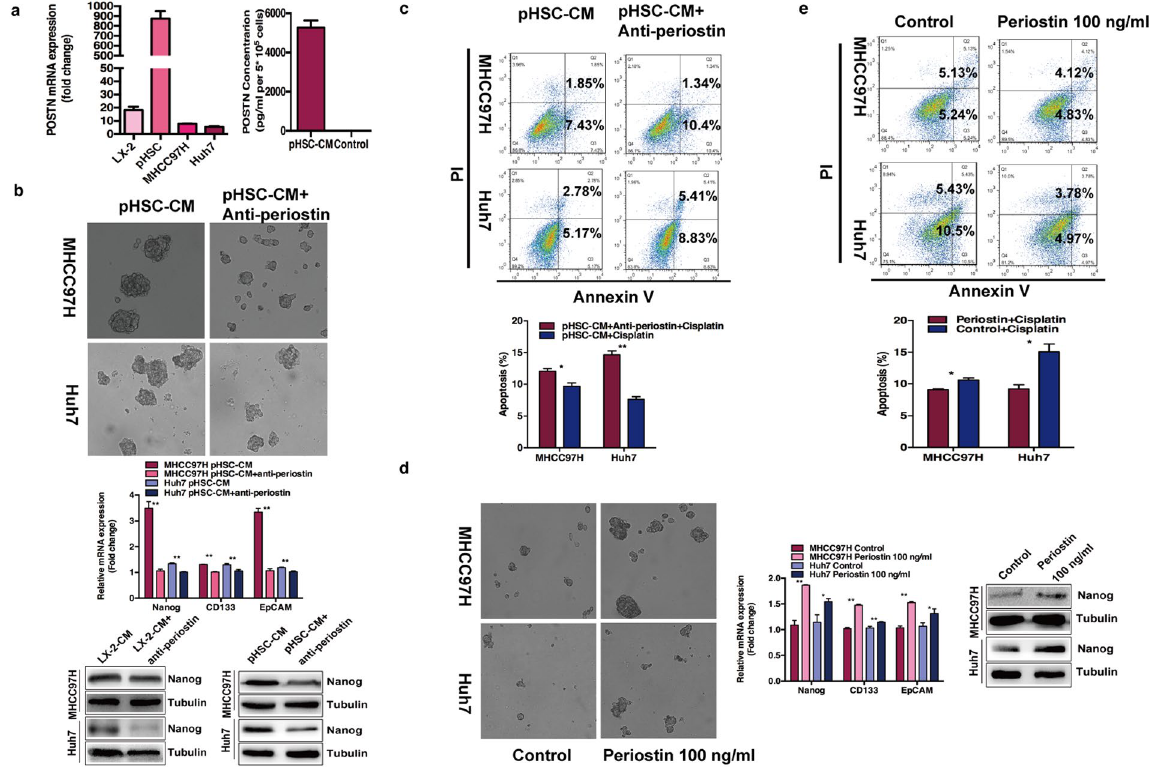
Figure 2. POSTN in the HSC-CM modulated the stemness of post heat-exposed residual HCC cells. ( a ) POSTN mRNA in HSC cells (LX-2, pHSCs) and HCC cells (MHCC97H, Huh7) was determined by quantitative RT-PCR. The concentration of POSTN in the HSC-CM were measured by ELISA assay. ( b , c ) Decreased spheroid formation ability and expression of Nanog, CD133 and EpCAM, and increased apoptosis to cisplatin in residual MHCC97H and Huh7 cells were observed after the removal of POSTN in the HSC-CM using POSTN-neutralizing antibody. ( d , e ) Supplement with 100 ng/ml recombinant POSTN increased the expression of Nanog, CD133 and EpCAM, and induced chemoresistances to cisplatin in the heat-exposed residual MHCC97H and Huh7 cells. ** P < 0.01; * P <